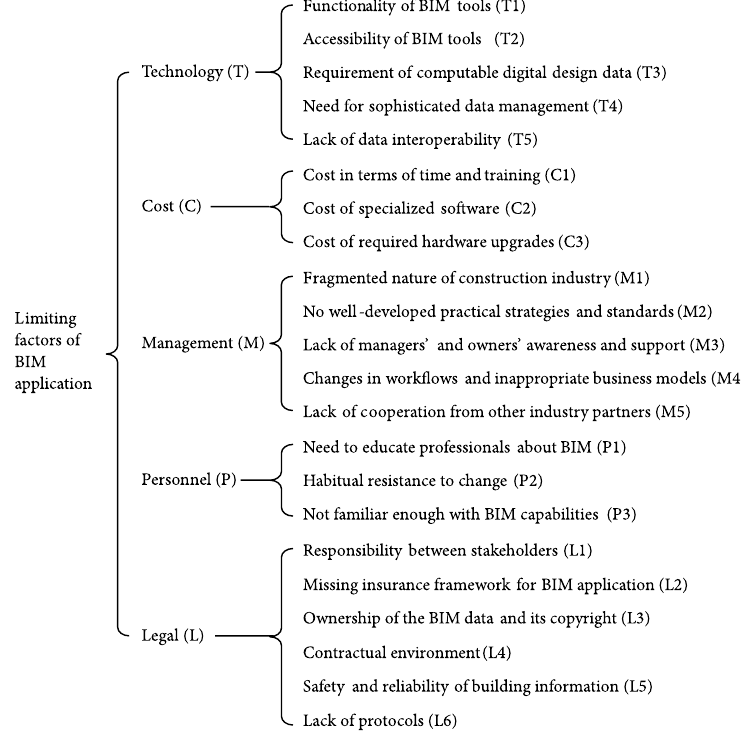
Fig. 1. Categories of factors limiting BIM